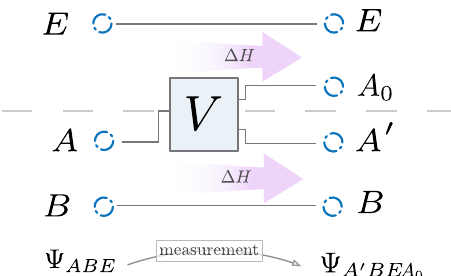
Fig. 6 Connection to entropy production. The key-generating measurement is regarded as an isometry to a larger Hilbert space, by expanding the classical memory A 0 with an ancilla A 0 . From this perspective the initial and fi nal states are pure, and thus the entropy change Δ H on the memory-Eve subsystem equals the entropy change on the Alice – Bob